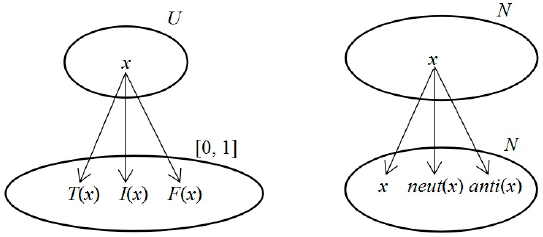
Figure 1. The contrast between neutrosophic sets and neutrosophic triplet groups.